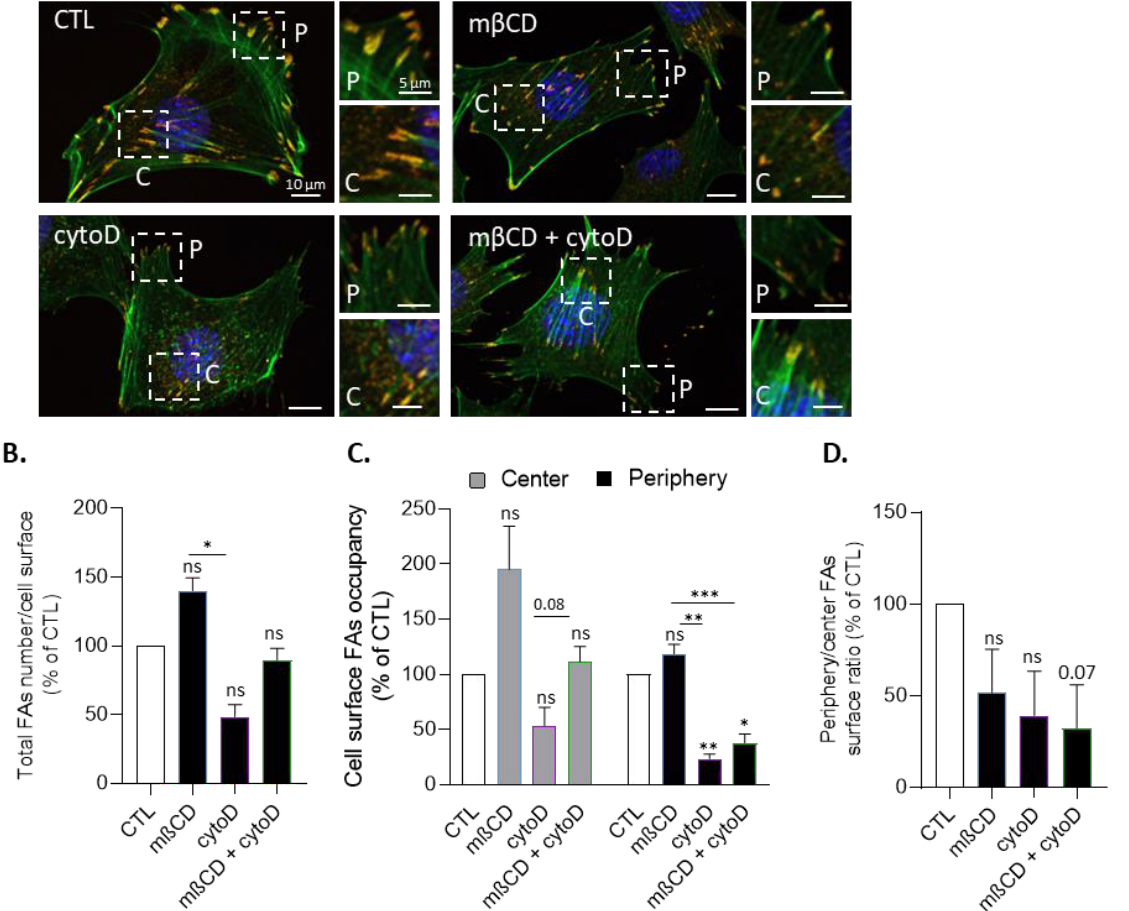
Figure 8. Cholesterol depletion and actin polymerization inhibition oppositely affect the total focal adhesion number and cell surface occupancy both at the center and the periphery of resting myoblasts but similarly impair their distribution at the periphery vs. the center. Cells were pretreated with 5 mM m β CD, 0.5 µ M cytoD, or a combination of both treatments then (immuno)labeled for F-actin (green), paxillin (orange), and nuclei (blue). ( A ) Representative images. P, periphery; C, center. ( B – D ) The quantification of FA number/cell surface ( B ), FA cell surface occupancy in the center, and periphery of the cell ( C ), and corresponding periphery/center FAs surface ratio ( D ). The data are expressed in % of the control (means ± SD, n = 3 independent experiments). Friedman test followed by Dunn’s multiple comparisons test and two-way ANOVA. The statistics above the columns refer to the control while statistics between different treatments are indicated with bars on top of the